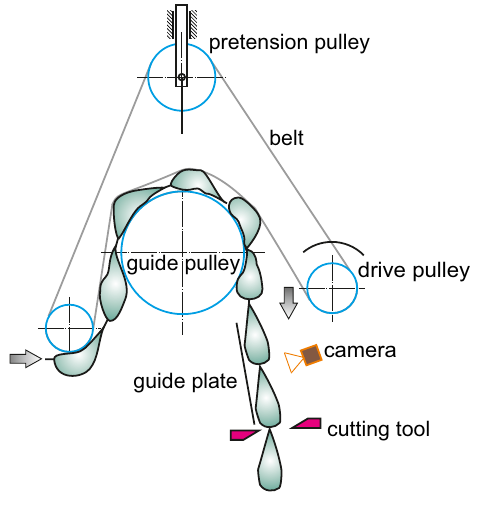
Figure 4. Drawing of the functional principle and the needed components ( a ) and the real setup at the Fraunhofer Institute for Material Flow and Logistics ( b